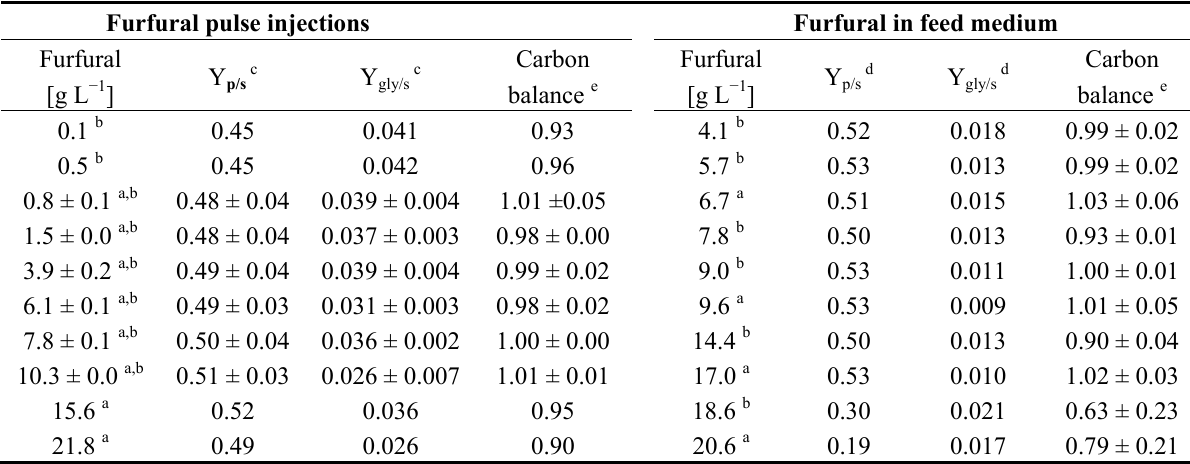
Table 1. Product yields and carbon balance during anaerobic continuous cultivations with either pulse injection or continuous furfural addition. The indicated furfural concentration is either the amount of furfural pulse injected to the cultivation or the level of furfural in the feed